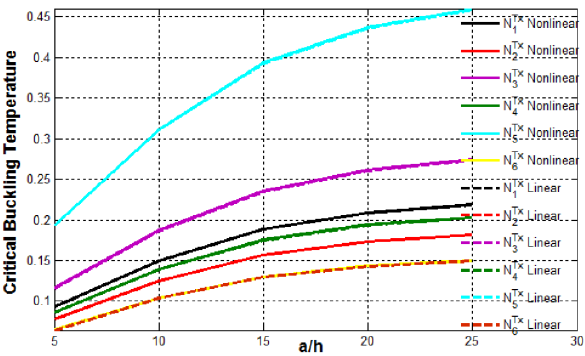
Figure 9: Variation in CBT with ESSWCNTRCLB aspect ratio